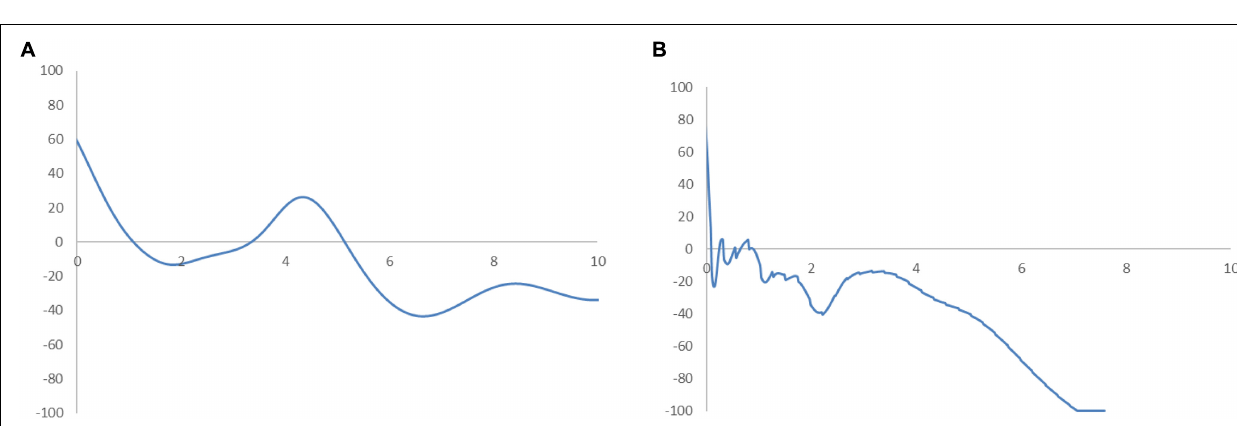
FIGURE 10 | Mobility probability plot (MPP) for the RSVAPC of countries for the Global North (A) and the Global South (B) . Source: Authors’ calculation. N.B. The vertical axis indicates net upward mobility (%) and the horizontal axis indicates RSVAPC